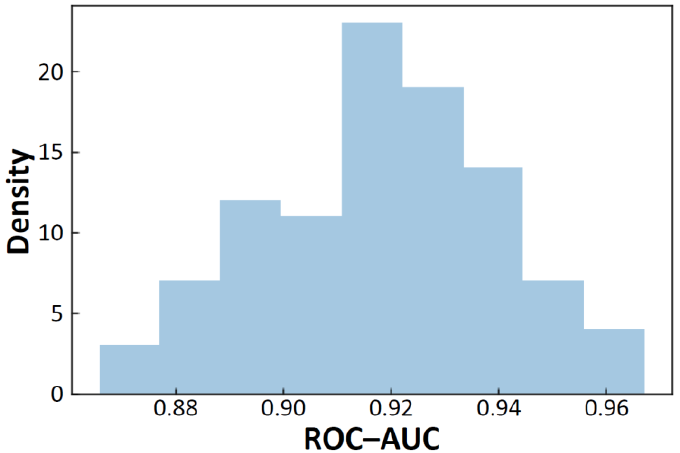
Figure 11. Distribution of ROC-AUC scores for RF:Free(Large212) with scaffold split.